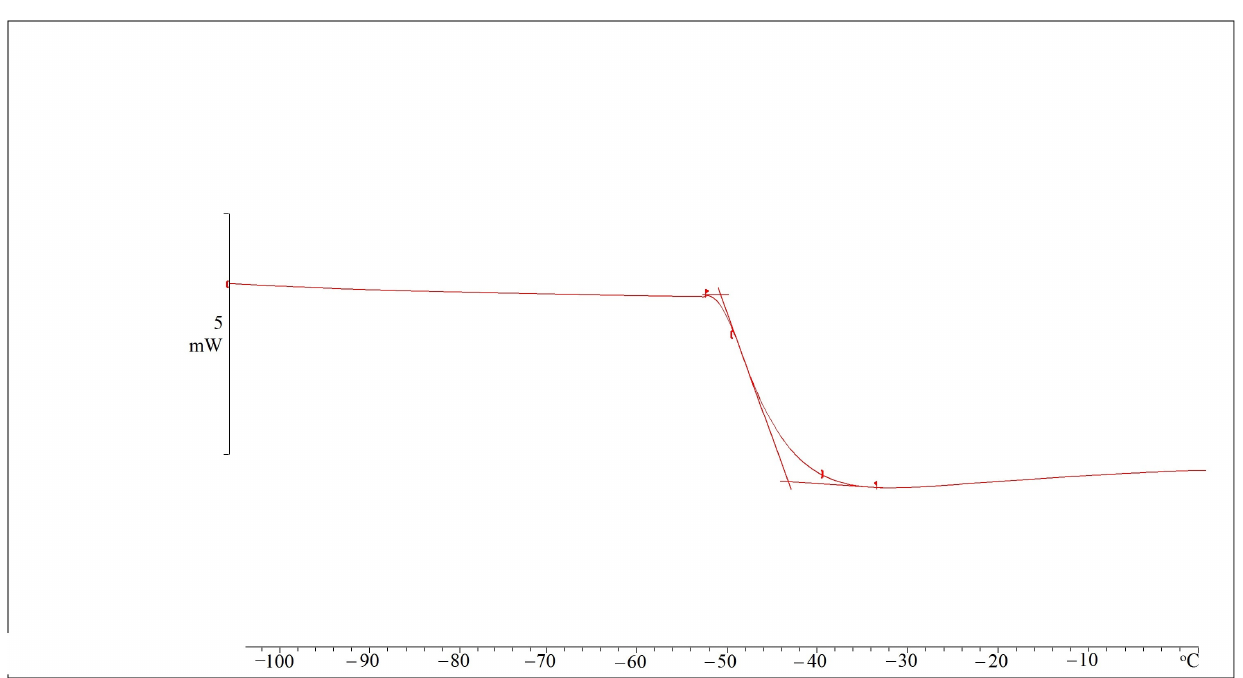
Figure 4. DSC thermogram of a PVC composition containing BPEA.